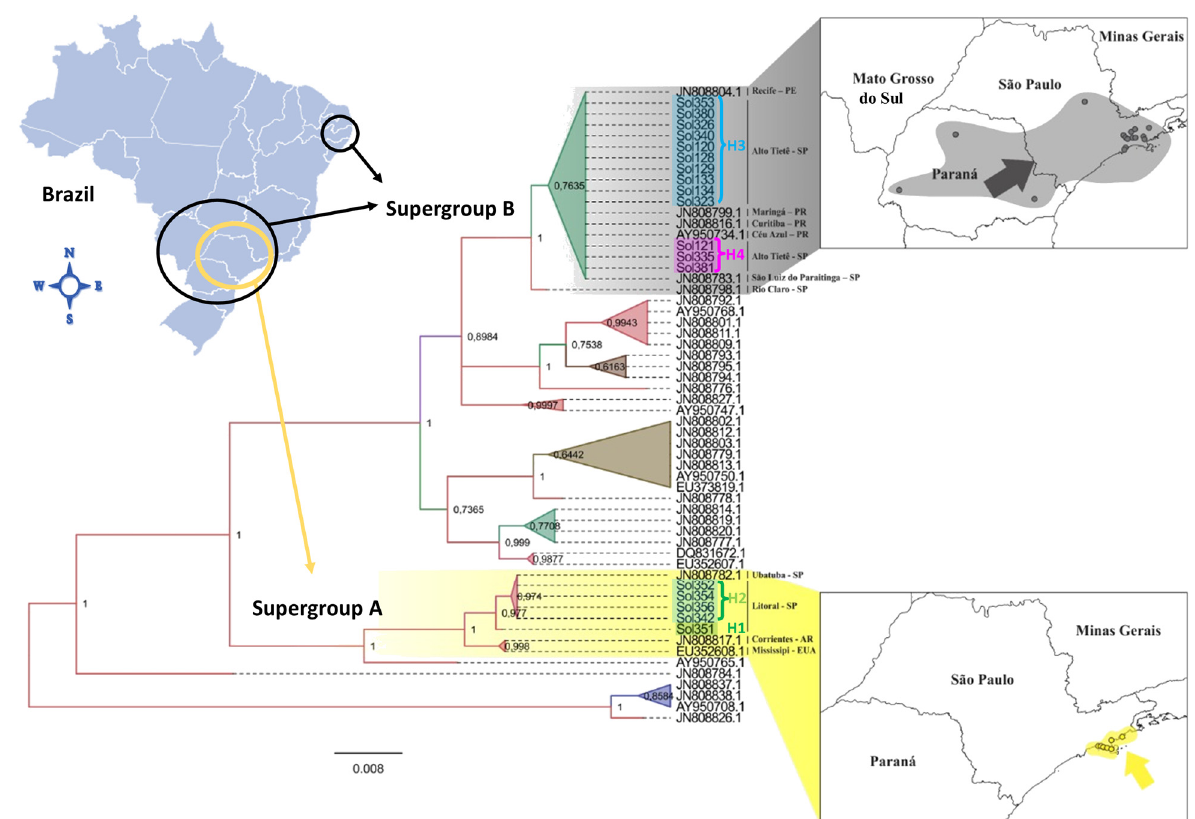
Figure 2. Phylogenetic tree generated by Bayesian inference showing different major lineages of Solenopsis invicta found in the south slope (supergroup A) and north slope (supergroup B) of Serra do Mar in the state of São Paulo, Brazil. Supergroup A is shown highlighted in yellow and includes haplotypes H1 and H2. Supergroup B, in gray, includes haplotypes H3 and H4.